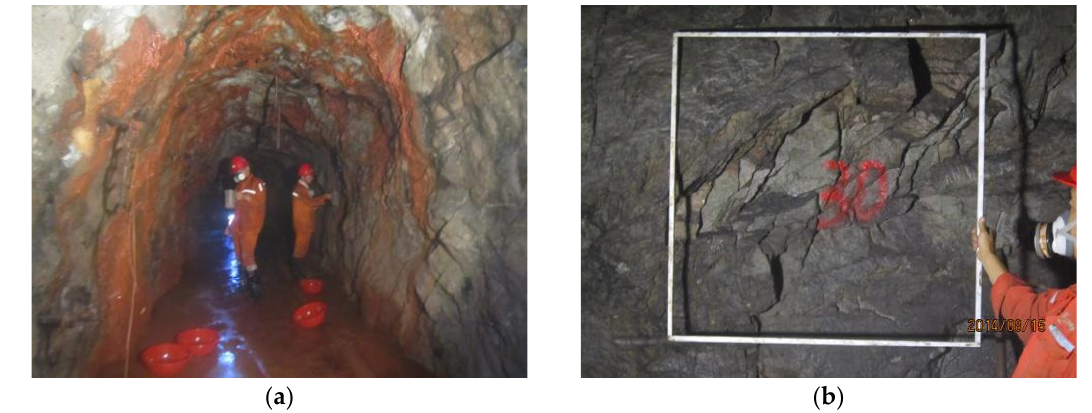
Figure 3. Investigation of roadway in deep mining. ( a ) Field survey; ( b ) fracture statistics.